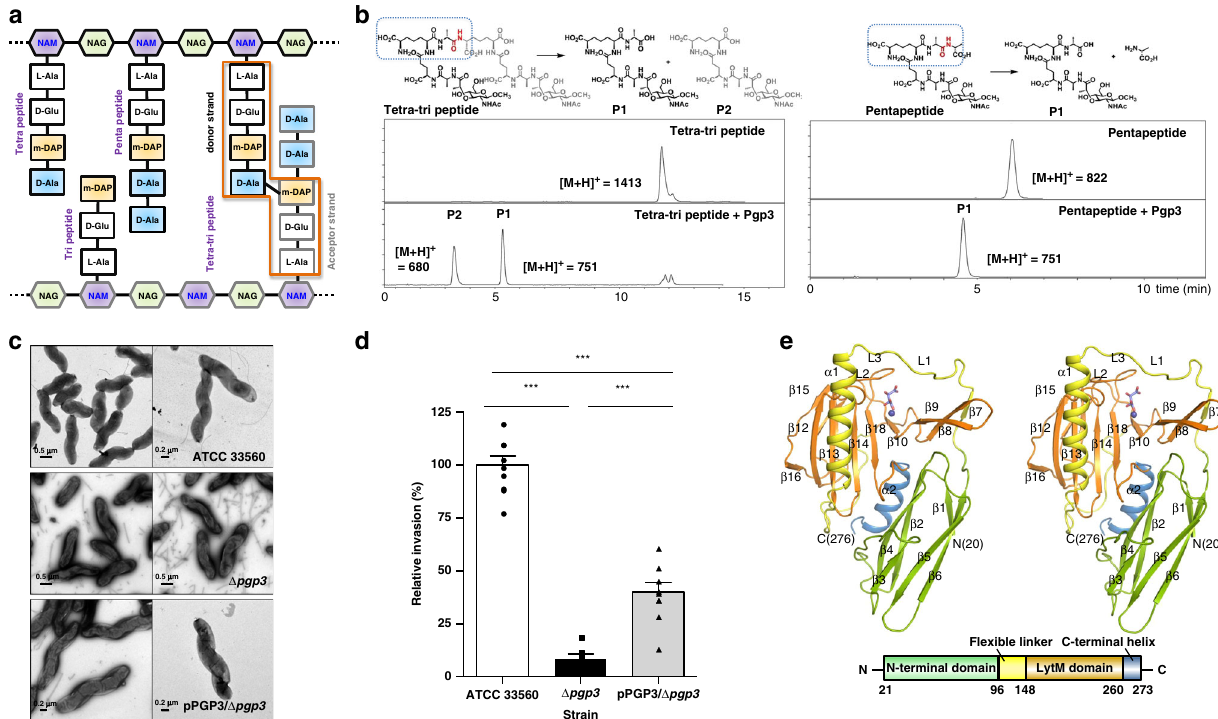
Fig. 1 Structural and functional characterizations of Pgp3. a Schematic diagram of peptidoglycan structure. b LC – MS traces of D , D -endopeptidase and D , D - carboxypeptidase activities of Pgp3 with tetra-tri peptide and pentapeptide, respectively. Acceptor strands of crosslinked peptides are shown in gray. The shared structural component between the two substrates is in blue dotted box. c TEM analysis of C. jejuni strains. C. jejuni ATCC 33560 wild-type, Δ pgp3 , and Δ pgp3 harboring pPGP3 were negatively stained with 2% (w/v) uranyl acetate and then observed by using TEM. Scale bars (lower left) represent 0.2 μ m or 0.5 μ m. d The effect of Pgp3 deletion on the host cell invasion. Caco-2 epithelial cells were with C. jejuni ATCC 33560 wild-type and Δ pgp3 , and Δ pgp3 -harboring pPGP3. The numbers of intracellular bacteria were determined 3 h after infection using the gentamicin-protection assay. Error bars represent the means and SEM from three independent experiments. The asterisks show statistical signi fi cance (***, P < 0.0001). Source data are provided as a Source Data fi le. e Domain architecture of Pgp3 and its stereo ribbon diagram. The N-terminal domain (NTD) and C-terminal domain (CTD) are shown in light green and blue, respectively, whereas the fl exible linker and LytM domain are drawn in yellow and orange, respectively. Tartrate molecule is shown as